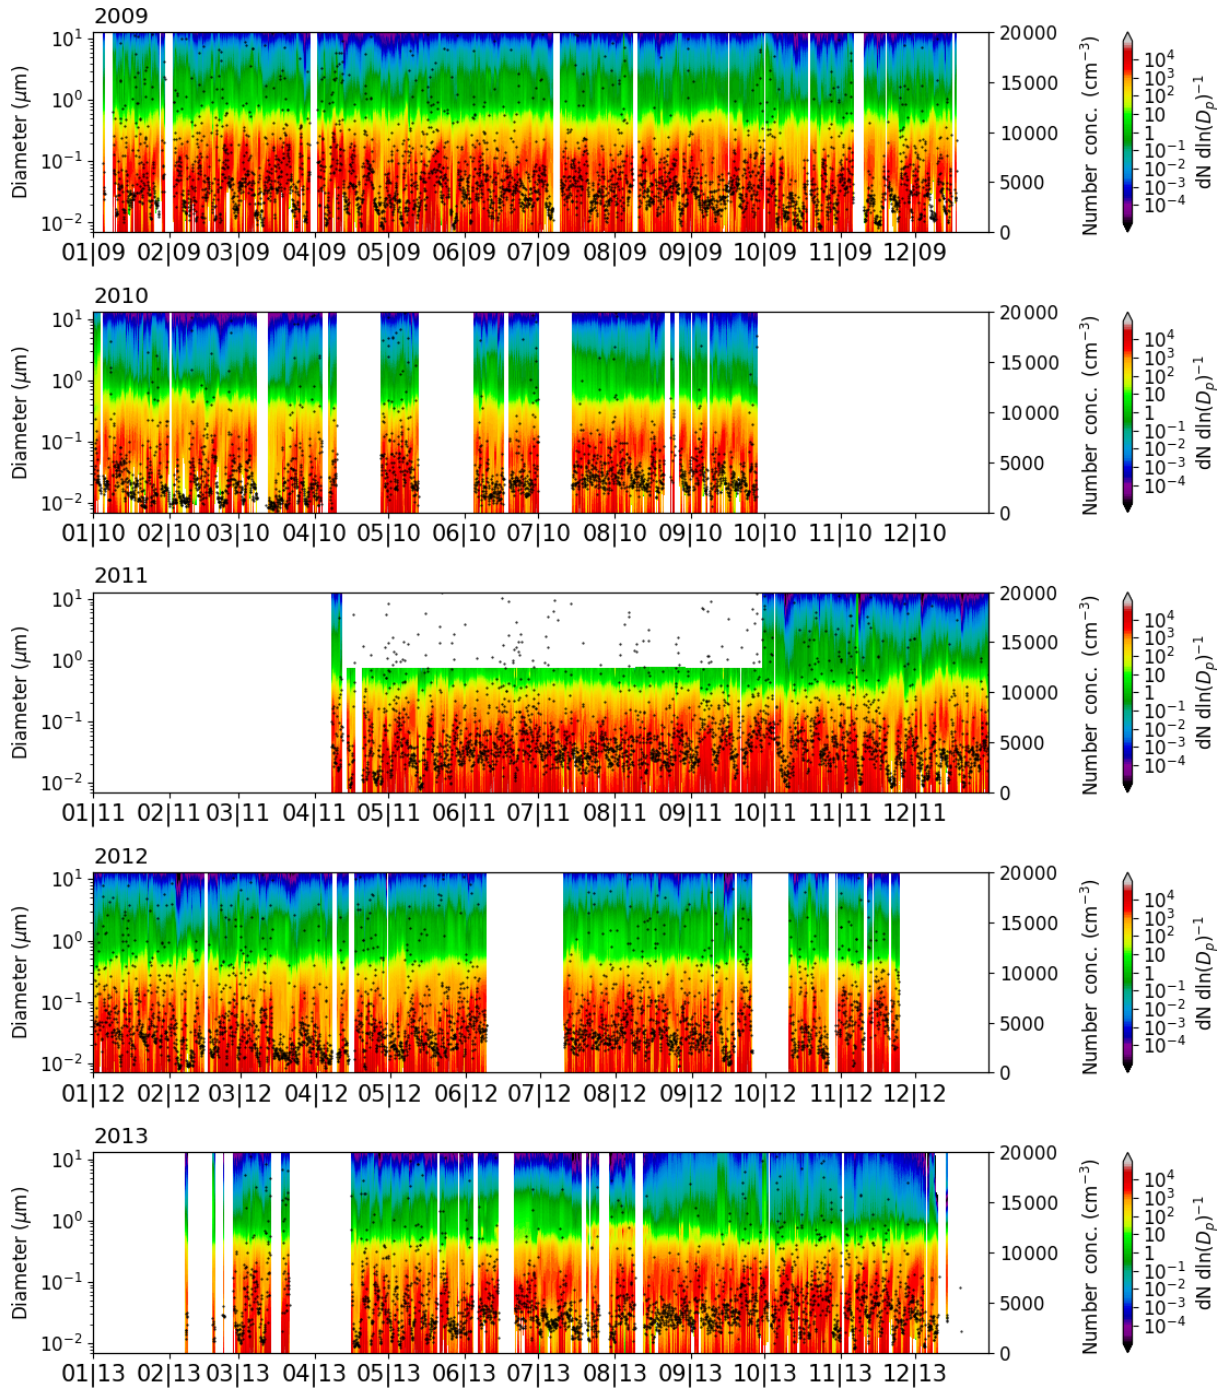
Figure 1. Time series of the final aerosol dataset used in this study following the quality control and the aerosol number size distribution ad- justments, as described in the Appendix. Each row represents 1 year from 2009 through 2013. The shading represents the value of the number size distribution, d N dln D − 1 p , as a function of diameter (left axis), and the black dots represent the total integrated number concentrations ( N T , right